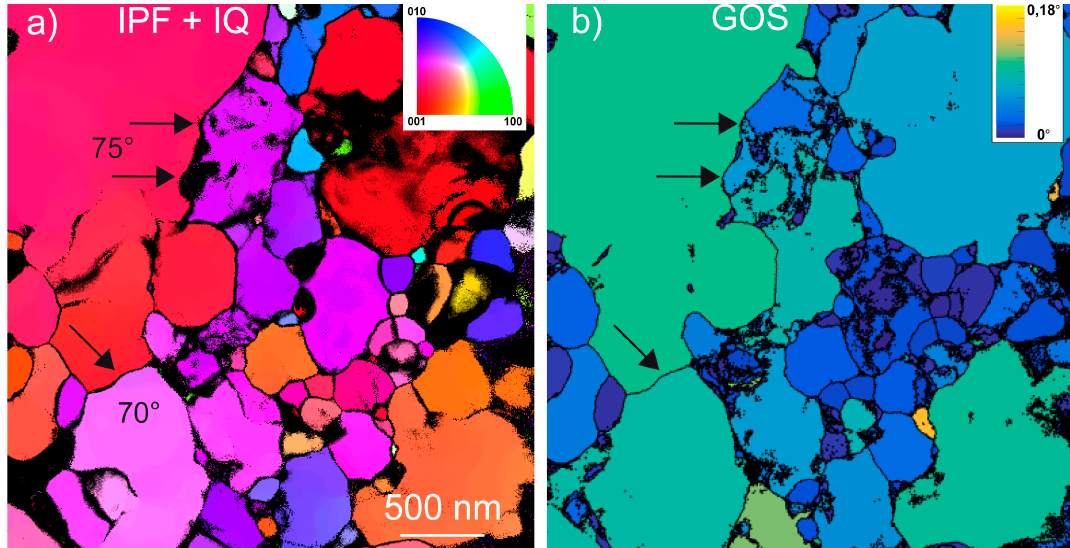
Figure 9. For70B small grains. ( a ) IPF corresponding to the direction perpendicular to the plane of view superimposed with the IQ (Equation (1)); color code inserted ( Pnma ). The misorientation of some boundaries (arrowed in black) are indicated next to them. ( b ) Grain orientation spread (GOS) map corresponding to ( a ).